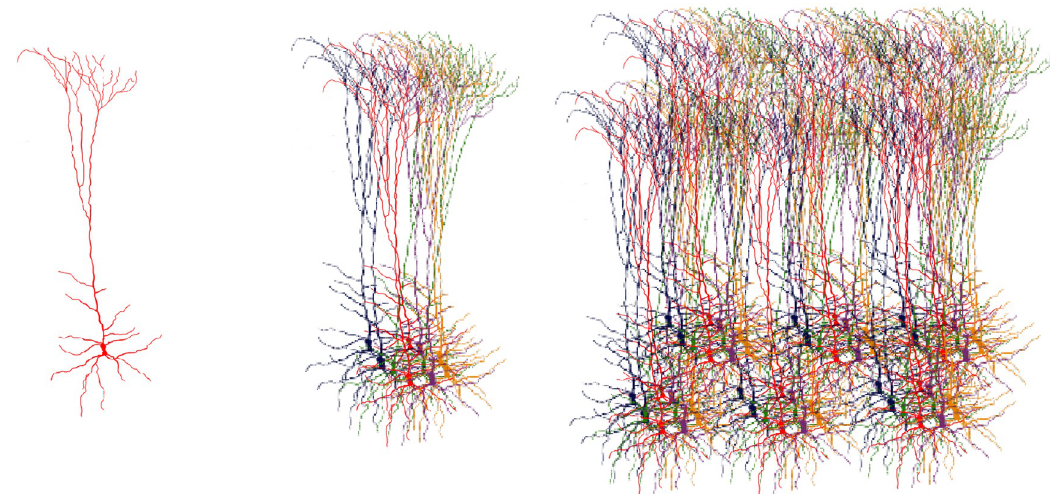
Fig 1. Cortical tissue organization. Left: Pyramidal cell. The most common excitatory neuron in cortical tissue. Center: Cortical mini-column. A cluster on neural cells which responds to stimuli of similar characteristics. Right: Cortical Column. A group of mini- columns with a common receptive field location. Adapted from (Fabuio, Own work, CC BY 4.0, https://commons.wikimedia.org/w/ index.php?curid=60707501).